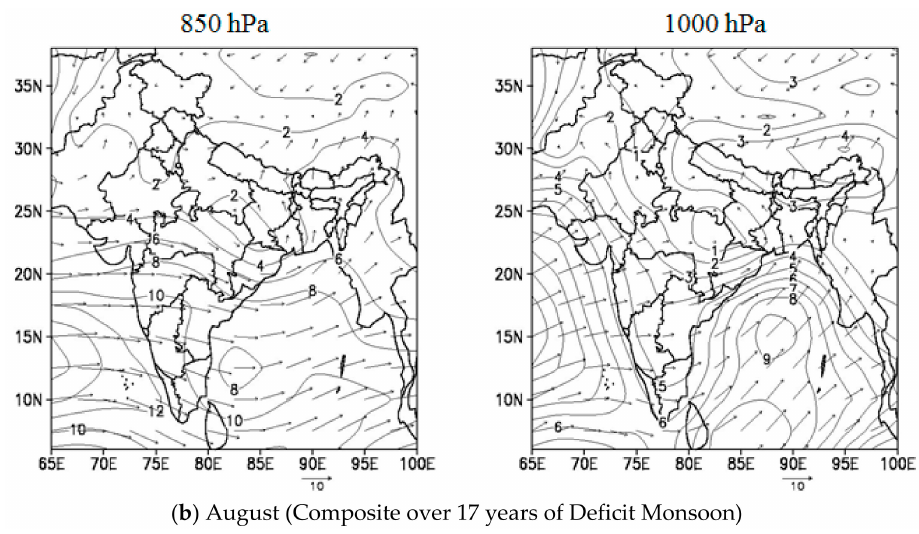
Figure 6. Composite climatology of wind circulation using NCEP reanalysis for the month of July ( a ) and August ( b ) at 850 hPa ( left ) and 1000 hPa ( right ) levels. The July (August) analyses are composited over excess (deficit) monsoon years.